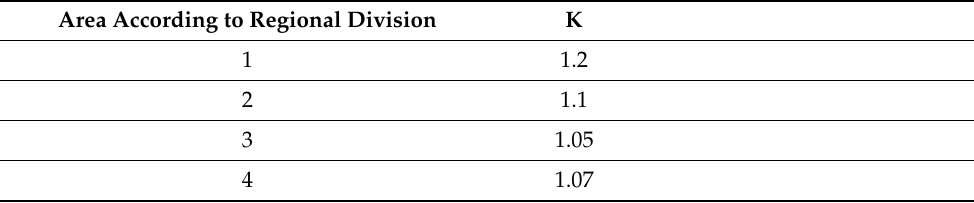
Table 3. Values of the compensation coefficient K for individual areas according to Figure 5. Area According to Regional